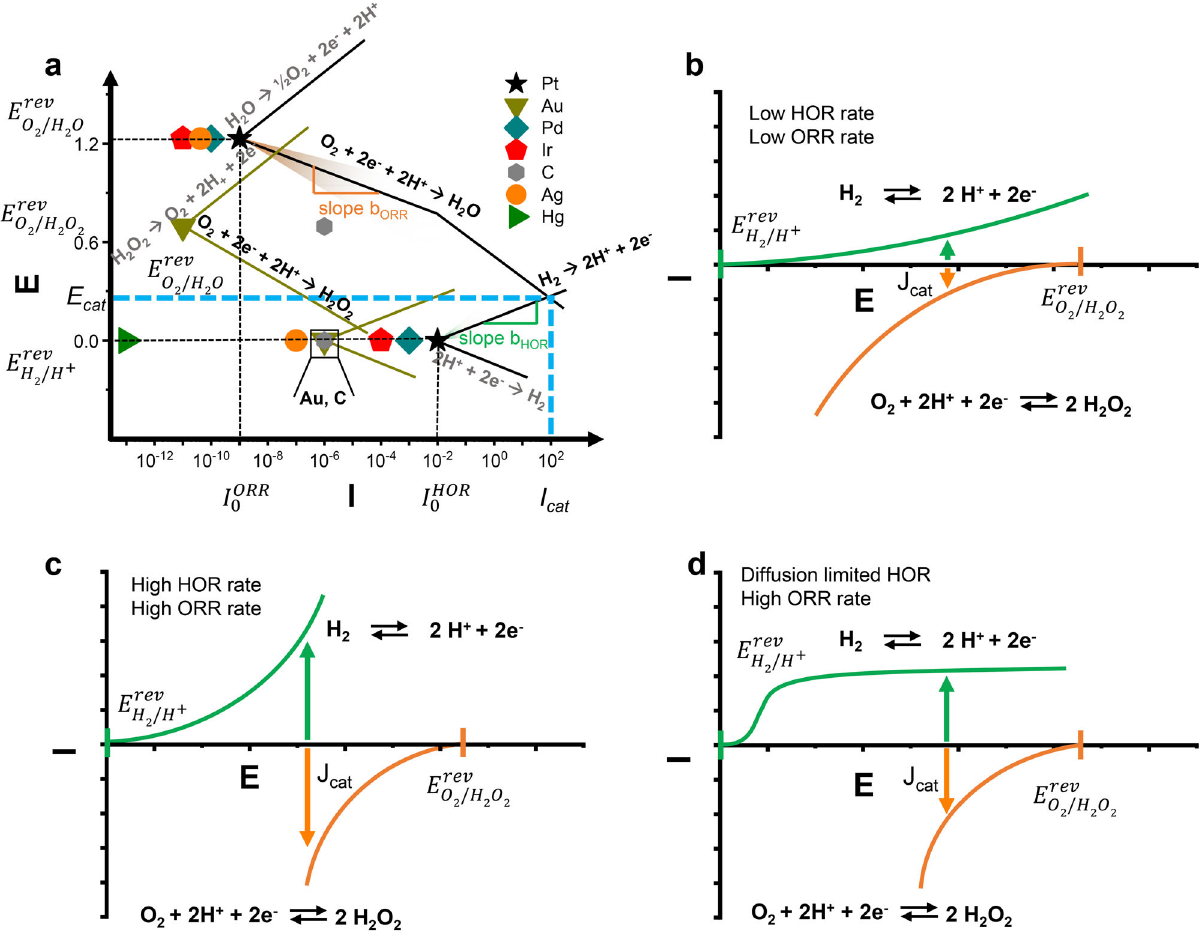
Fig. 2 Current – voltage curves and complied Evans diagram for HOR and ORR. a Evans diagrams compiled from a variety of catalysts which have been reported as HOR and ORR catalysts. An exhaustive overview of all parameters can be found in Table S1. Independent current-voltage curves of both half- cell reactions with low ( b ) and high ( c ) HOR and ORR rates as well as one reaction being diffusion limited ( d ) in the framework of the mixed-potential